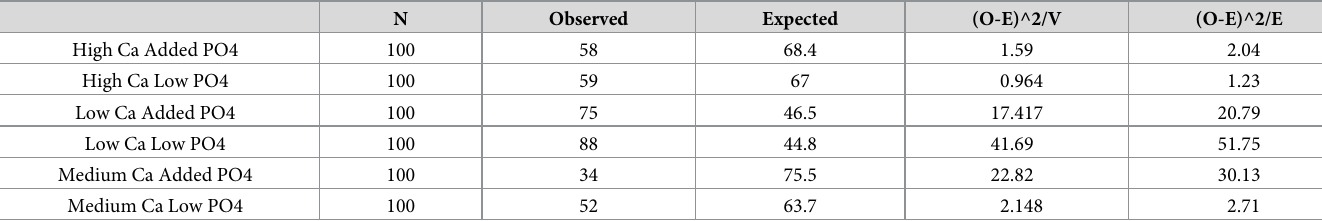
Table 3. Log-Rank test for differences in survival probability between the 6 treatment groups. Chisq = 94 on 5 degrees of freedom, p = < 2e-16.